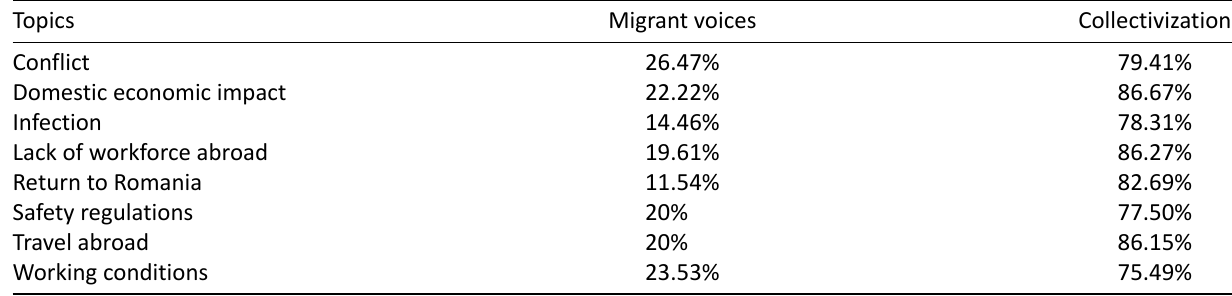
Table 1. The weight of migrant voices and collectivization along with the various topics (percentages of total articles coded with each topic).